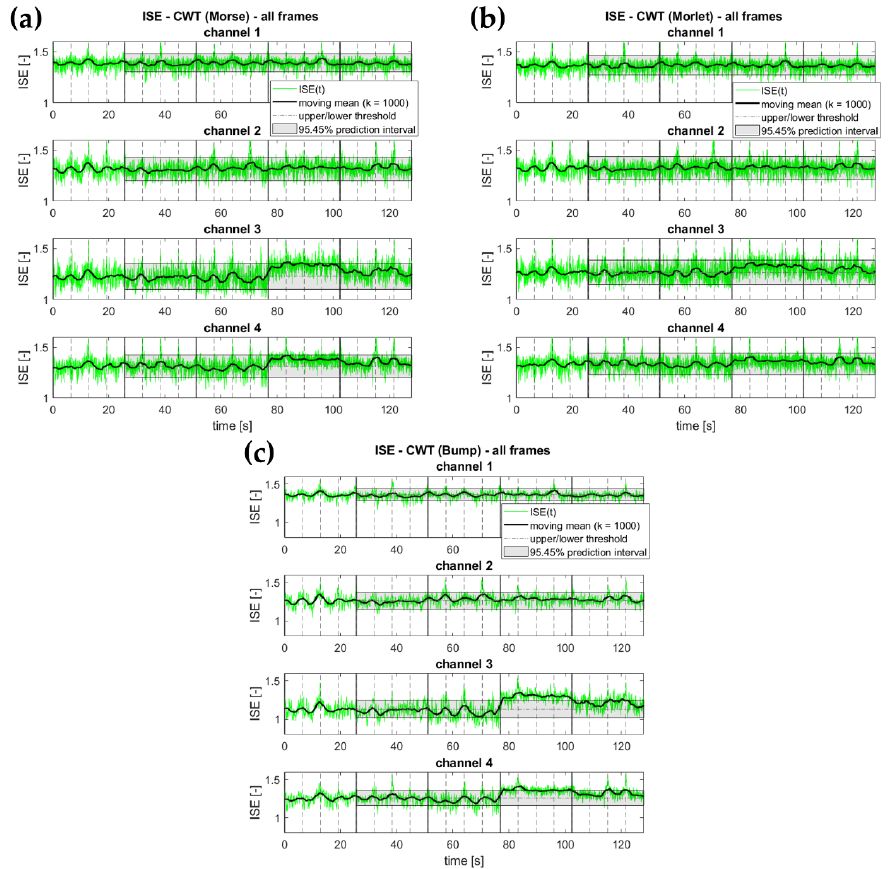
Figure 5. Results for the Shannon spectral entropy. Continuous wavelet transform with ( a ) Morse, ( b ) Morlet, and ( c ) bump wavelets.